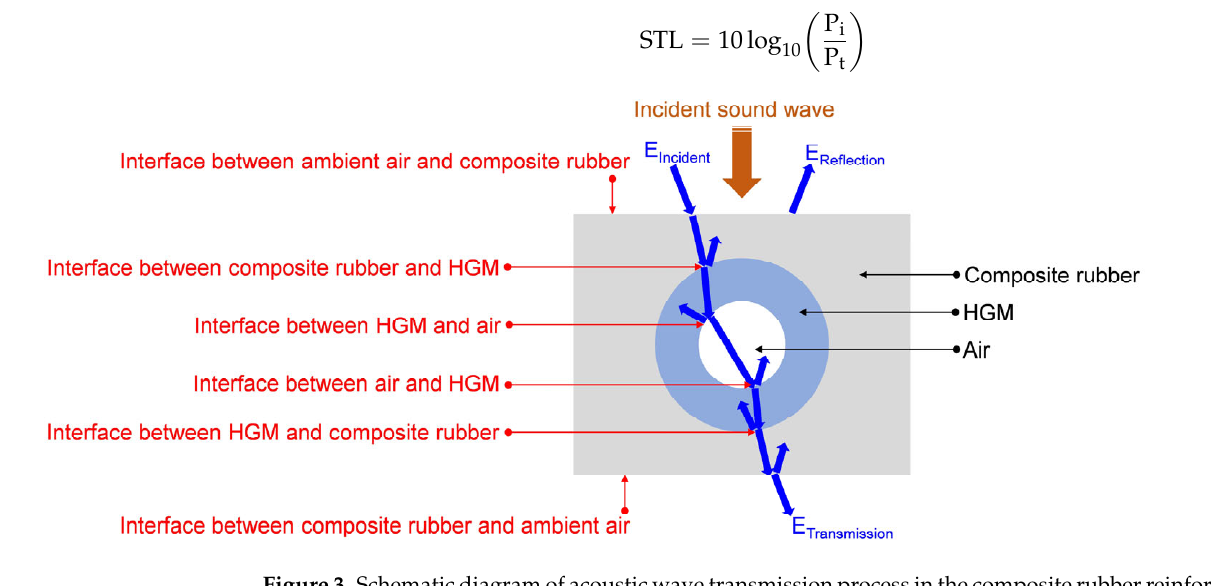
Figure 3. Schematic diagram of acoustic wave transmission process in the composite rubber reinforced with the HGM.